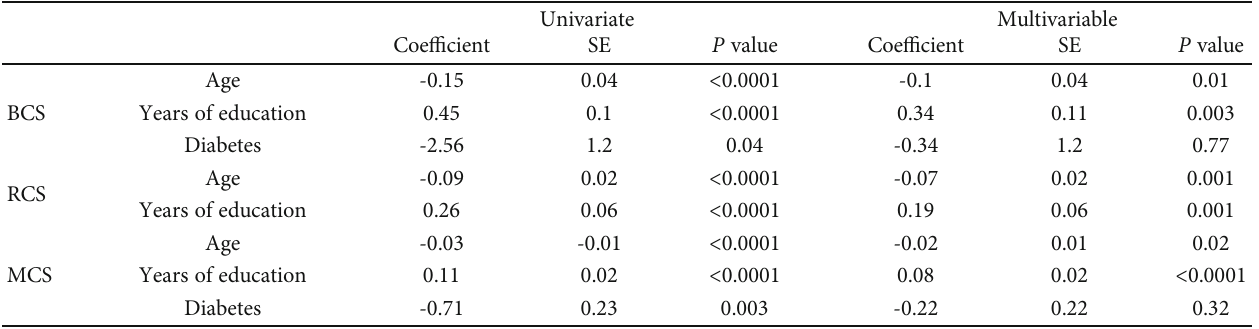
Table 2: Multivariable regression with variables that were signi fi cant in the univariate analysis for the BCS, RCS, and MCS.